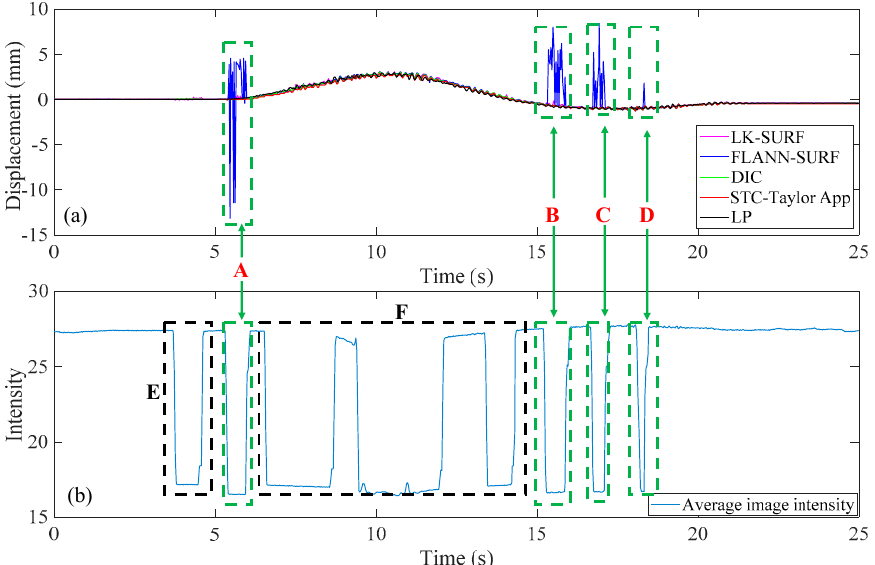
Figure 15. Case 2 (illumination change): ( a ) displacement time histories of P1 obtained from different methods and ( b ) average image intensity time history.